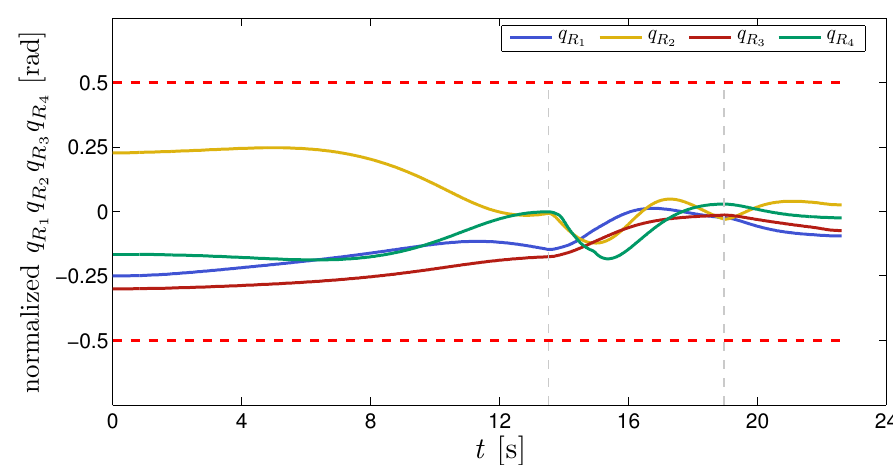
Figure 14. Changes of the configuration variables for the right arm.